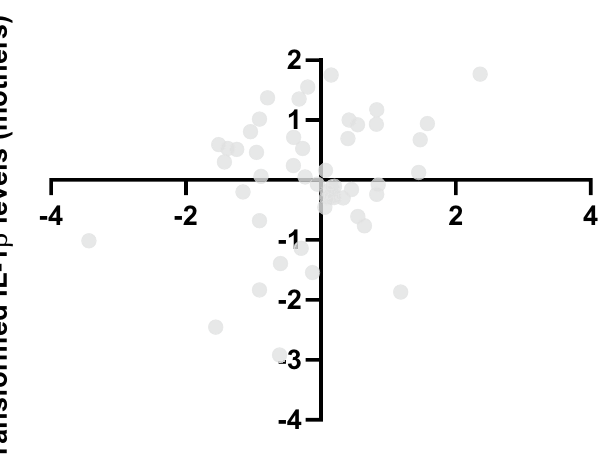
Figure 4. Correlation in transformed IL-1β levels between mothers and their depressed/anxious daughters. No correlation was found between IL-1β levels in female patients and their mothers (Spearman correlation: R = 0.127, p value = 0.38, adj. p value =